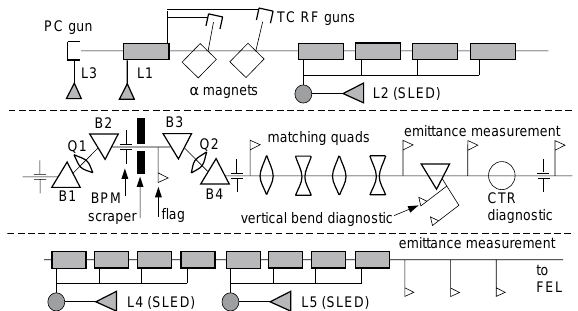
FIG. 1. Schematic of the Advanced Photon Source (APS) linac with the bunch